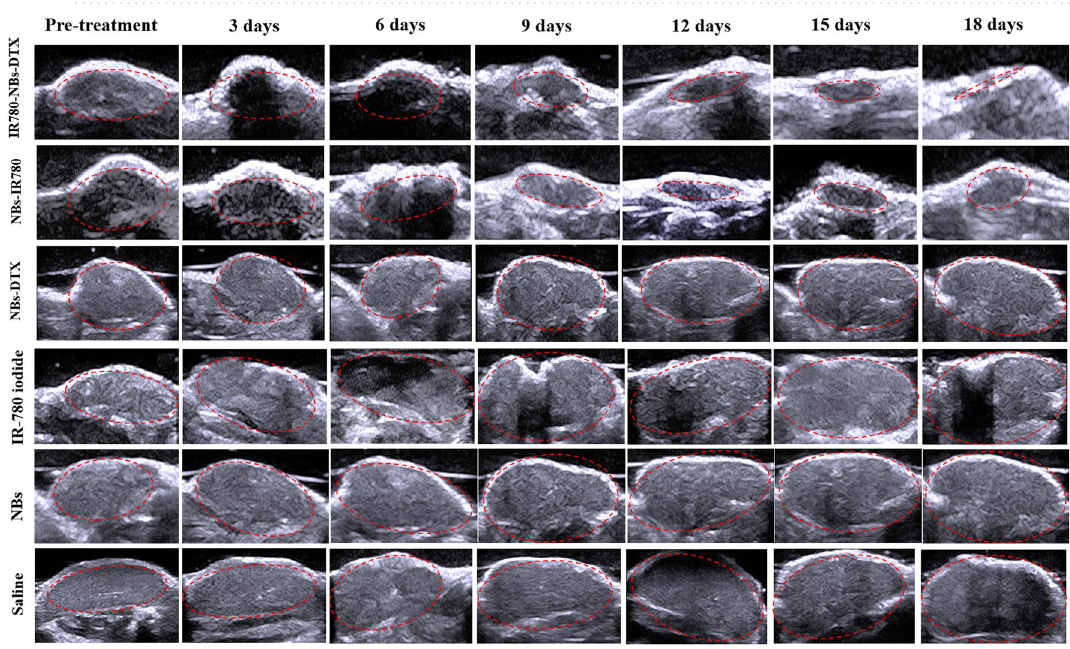
Figure 13. Changes in tumor volume were monitored by traditional ultrasound before and after combined treatment with different contrast agents (IR780-NBs-DTX, NBs-IR780, NBs-DTX, IR-780 iodide, NBs group, and saline). Red dotted lines represent tumors observed by ultrasound